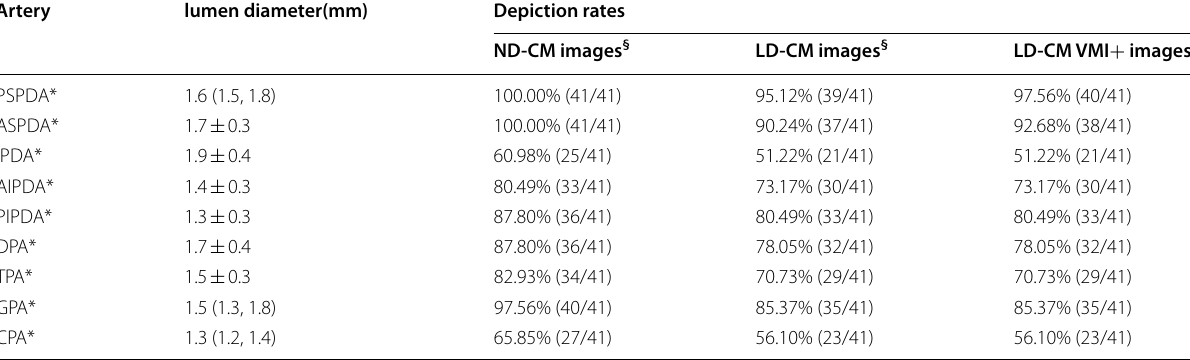
* PSPDA posterior superior pancreaticoduodenal artery, ASPDA anterior superior pancreaticoduodenal artery, IPDA inferior pancreaticoduodenal artery, AIPDA anterior inferior pancreaticoduodenal artery, PIPDA posterior inferior pancreaticoduodenal artery, DPA dorsal pancreatic artery, TPA transverse pancreatic artery, GPA great pancreatic artery, CPA caudal pancreatic artery §